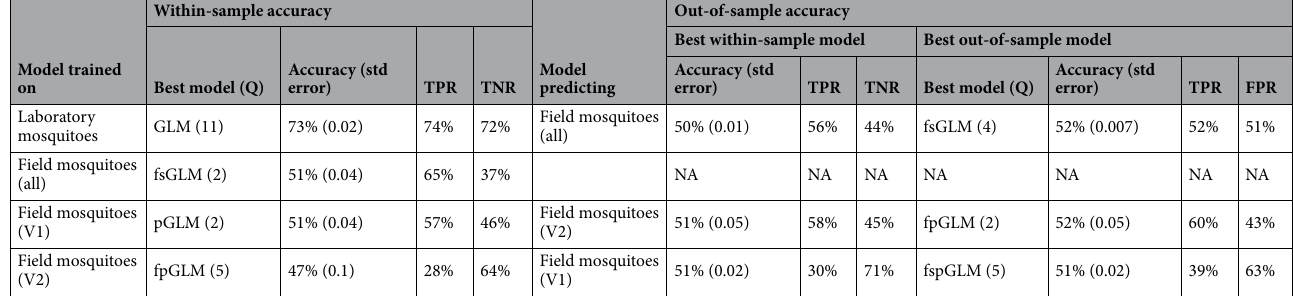
Table 2. Summary of overall accuracy of the different NIRS models for predicting presence of sporozoites. Models were trained on either laboratory or field mosquitoes, either all mosquitoes grouped together (all) or separately for mosquitoes from the villages of Longo (V1) or Klesso (V2). The number of PLS components ( Q ) is presented alongside overall models accuracy (the percentage of mosquitoes correctly classified), the